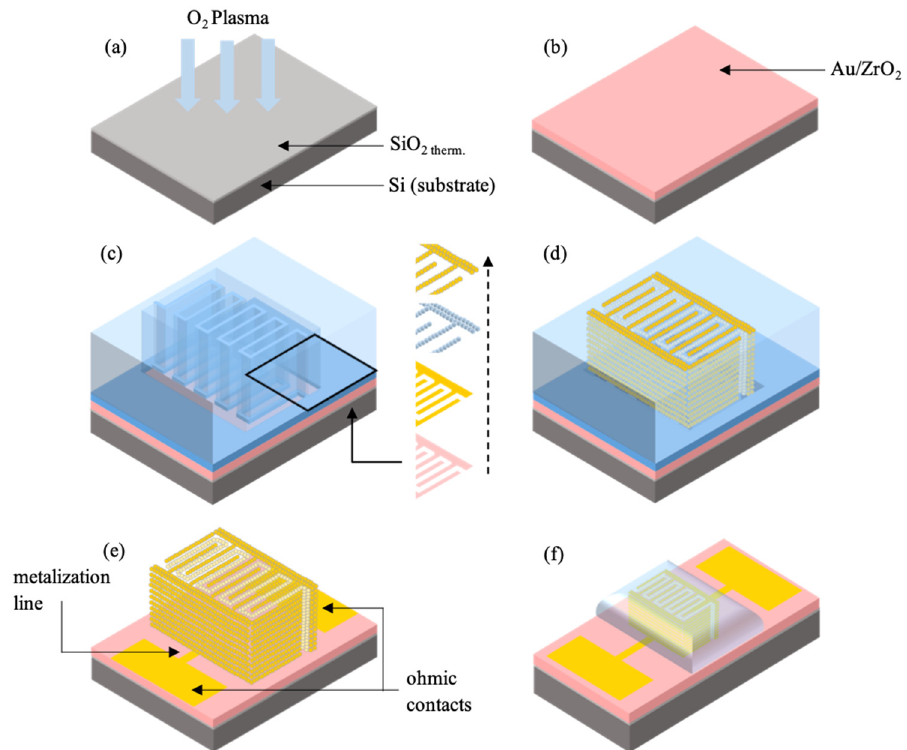
Figure 1. Schematic diagram of the porous gold-based micro-supercapacitor fabrication process. ( a ) Substrate functionalization by O 2 plasma treatment; ( b ) Au/ZrO 2 adhesion/seed layer deposited by dip-drawing; ( c ) photolithography process and porous gold film growth (gold electroless plating, template deposition and template metallization); ( d ) Au/PS multilayered film deposited by dip-drawing, ( e ) photoresist removal and electric contact deposited by sputtering; ( f ) gel polymer electrolyte incorporated by dip-drawing and by applying vacuum.